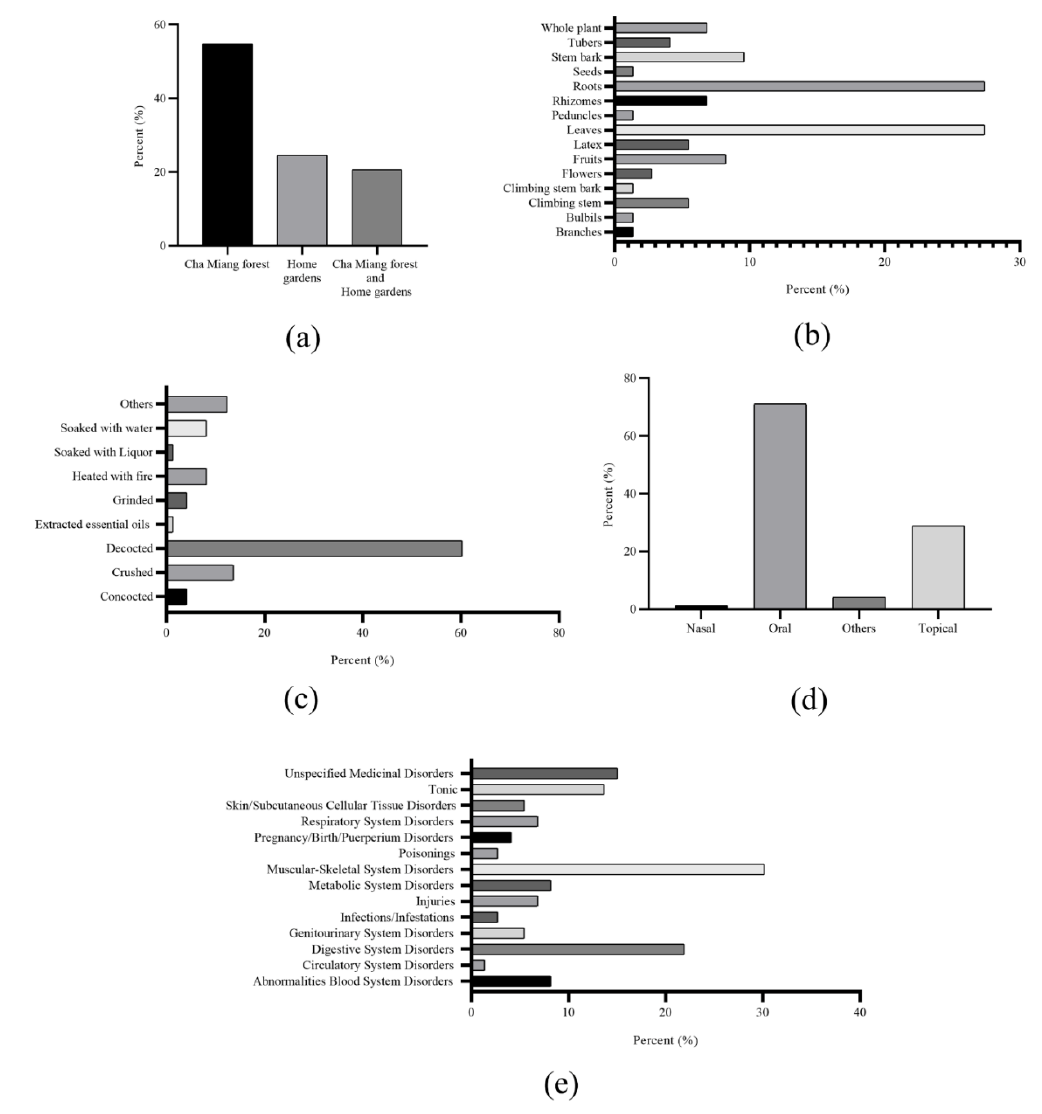
Figure 1. ( a ) Medicinal plants’ habitats; ( b ) percentage of plant parts used from medicinal plant species; ( c ) percentage of medicinal plant preparation methods; ( d ) percentage of administration routes; ( e ) percentage of plant species used as ethnomedicine for a particular ailment.